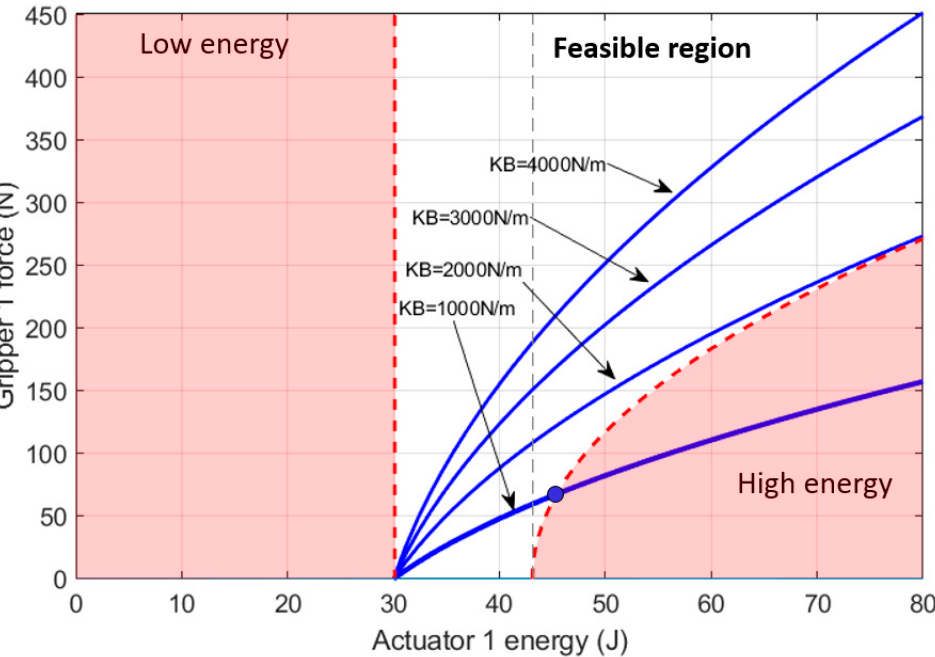
Figure 16. Feasible region of the energy imposed by actuator 1 for exerting force on the gripper attached to its compliant actuator. Four di ff erent springs were analyzed for cable section 1 B . The boundaries were applied for the case of K B = 1000 N/m, where the range of feasible force is F 1 BA ∈ ( 0, 72.8 ) N.